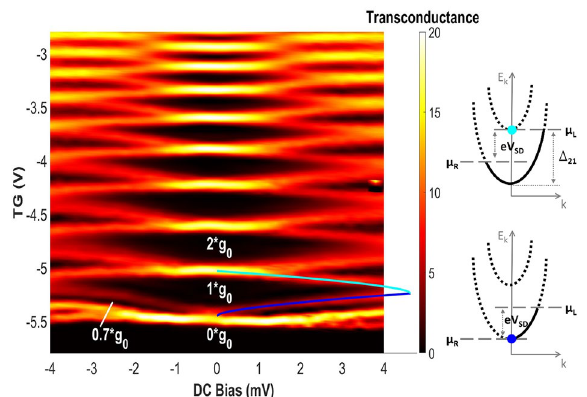
Figure 5. Transconductance dependence on dc bias and top-gate voltage of a 2 μm wide wire at 25 mK with 6 μV ac excitation. Transconductance is plotted as a function of the dc bias and top-gate voltage giving rise to diamond shaped, dark areas separated by regions of high transconductance. Using the model of Picciotto et al. 13 the shape of the transitions is calculated and is depicted by blue and magenta lines. Along the transconductance transitions either the chemical potential of the source µ L or the drain µ R is aligned with a sub-band, as shown in the schematic of the parabolic energy